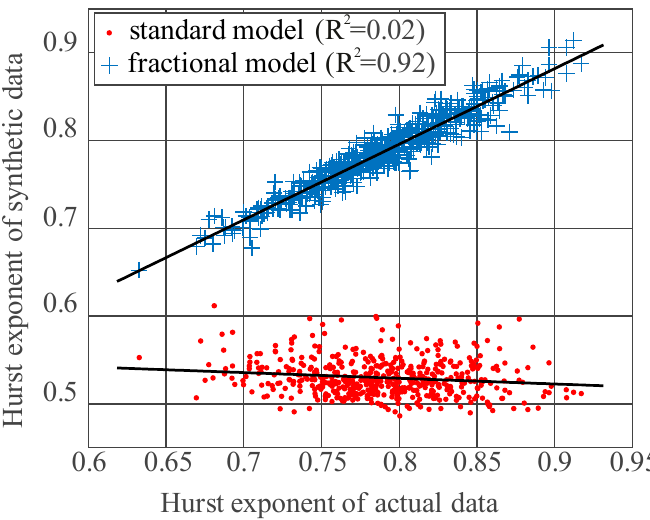
Figure 11. Hurst exponent of simulated and actual wind speed data.